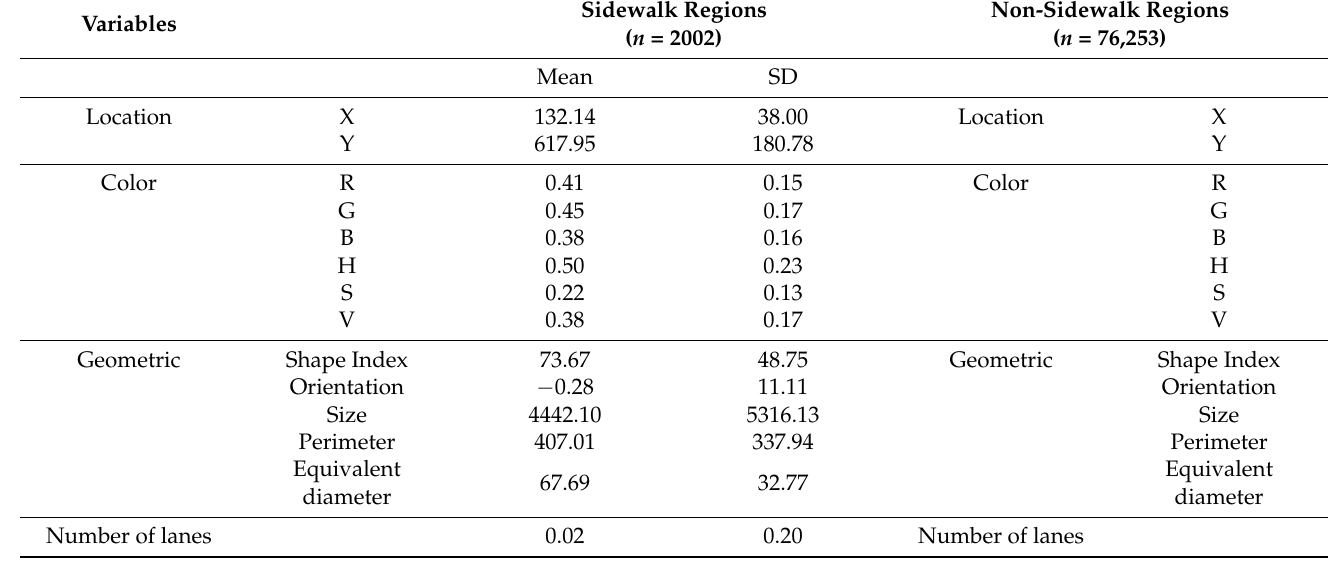
Table 1. Segmented image region: descriptive statistics before standardization.